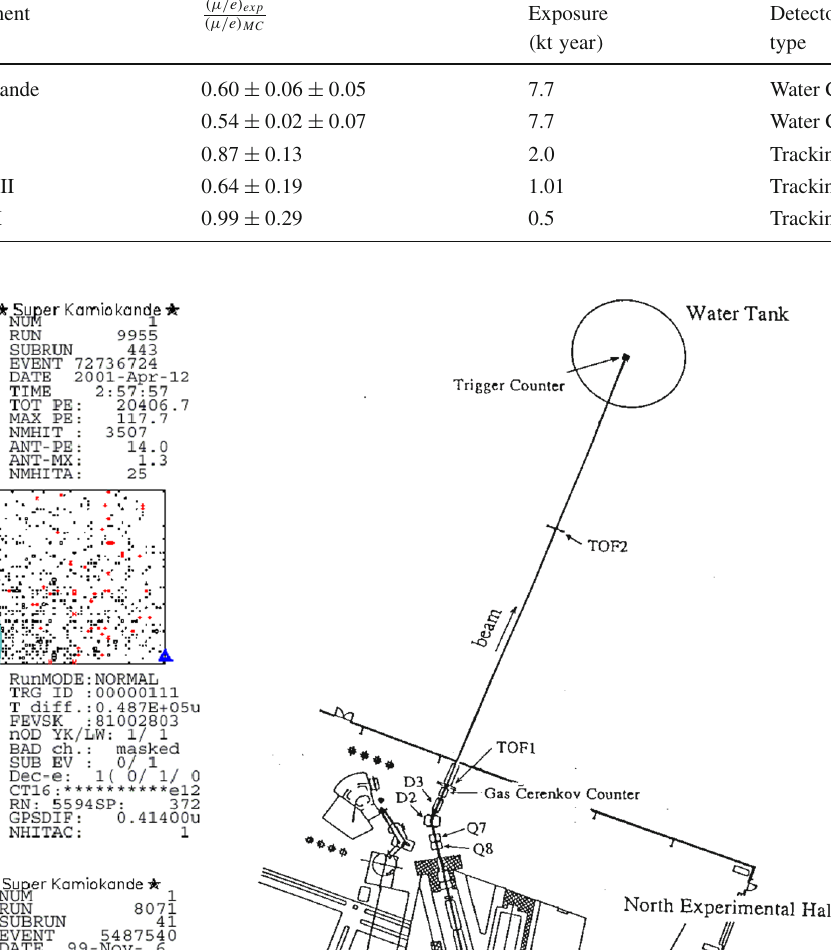
Table 1 Results on atmospheric neutrino observations around